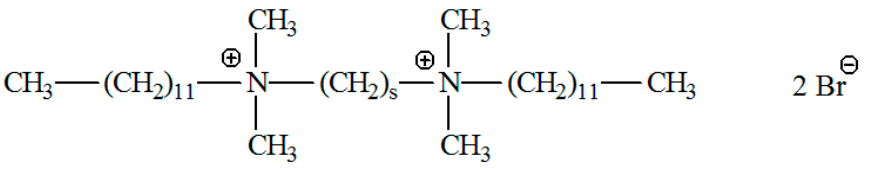
Figure 14. Molecular structures of the gemini surfactants 12- s -12.